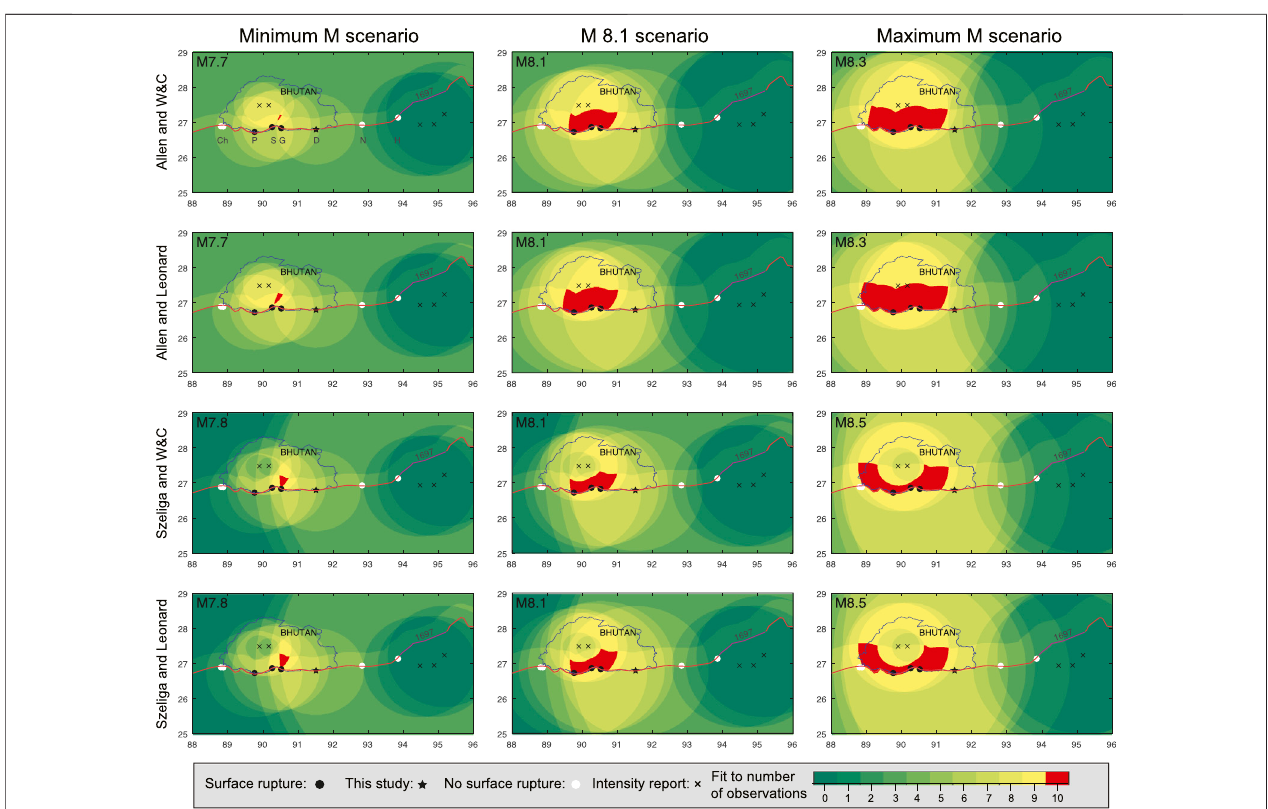
TABLE 3 | Tested scenarios and parameters used in the magnitude calculations. Combinations of equations and parameters used for estimated magnitude calculations of the 1714 Bhutan earthquake shown in Figure 9 . For the intensity observations please see (Hetényi et al., 2016). Tested scenarios Allen and W&C: Allen and Leonard: M7.7-8.3